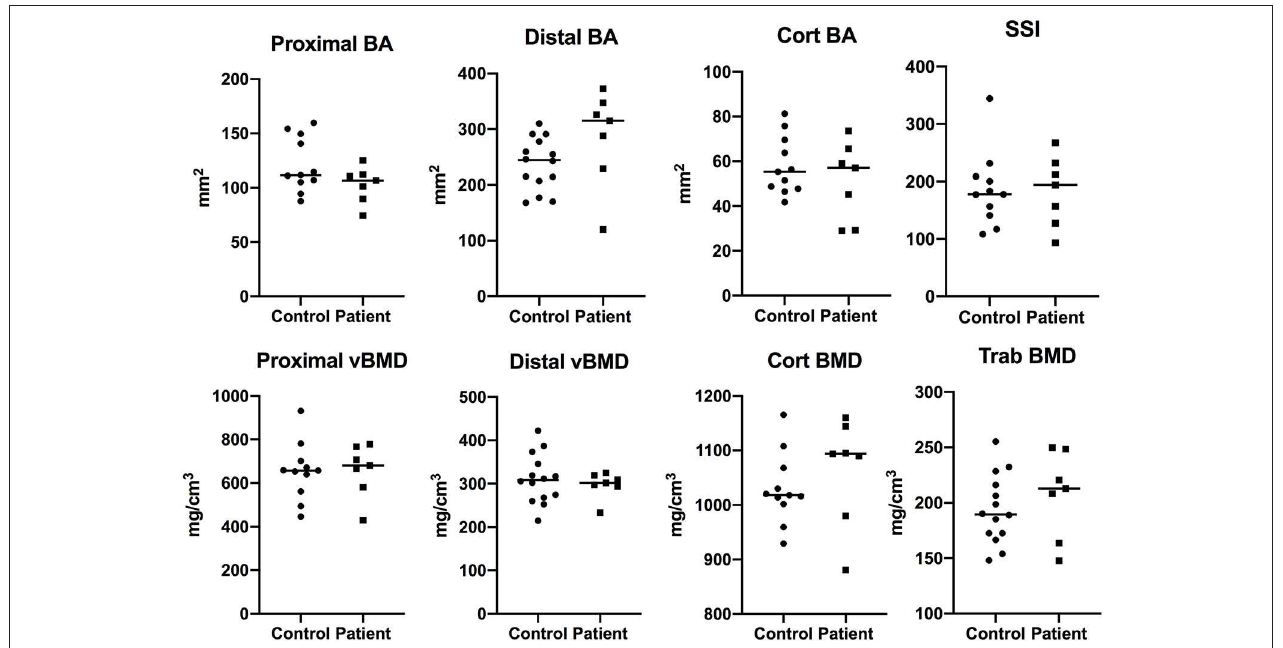
FIGURE 1 | Bone characteristics at radial site in children with APECED ( n = 7) in comparison to age- and gender-matched control children ( n = 14). Total and cortical bone area (BA), total, cortical, and trabecular volumetric bone mineral density (vBMD), and strength-strain indices measured at proximal (66%) and distal (4%) site of radius with